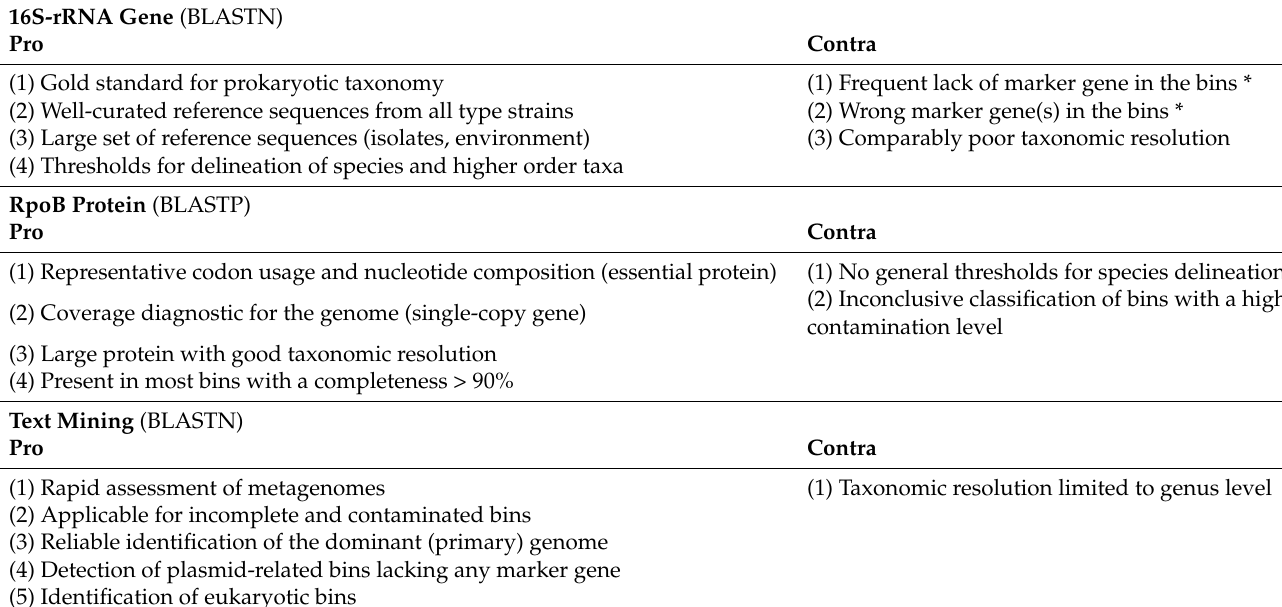
Table 3. Comparison of 16S-rRNA, RpoB and text mining approaches for the classification of metagenomic